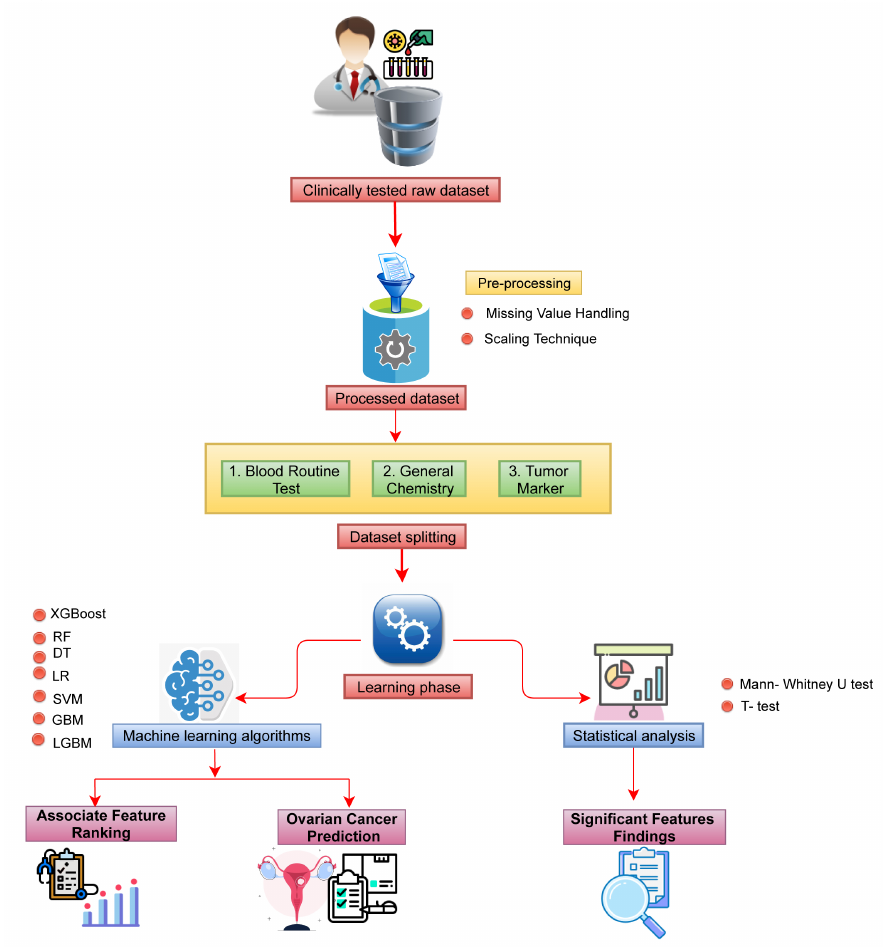
Figure 1. The schematic diagram of the overall